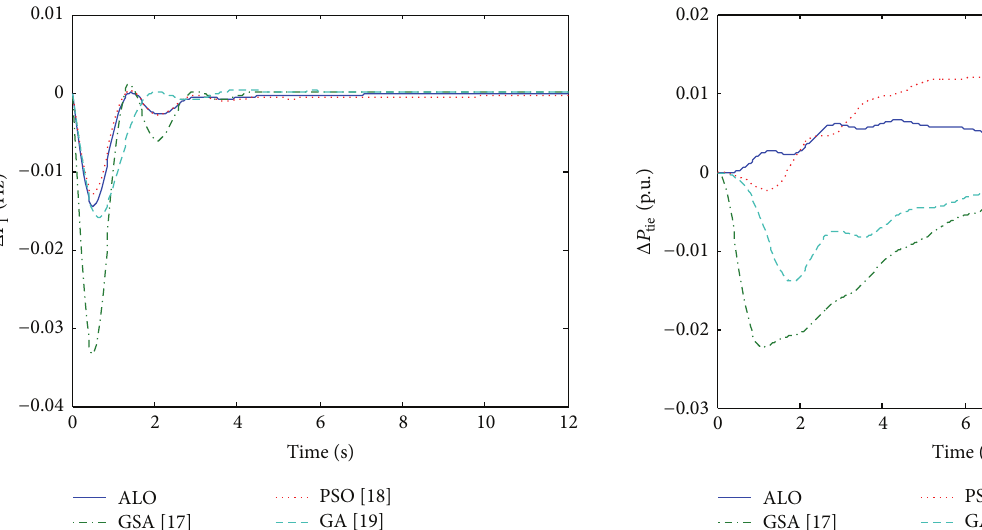
Figure 6: Change in tie-line power by 10% load increase in area 1.